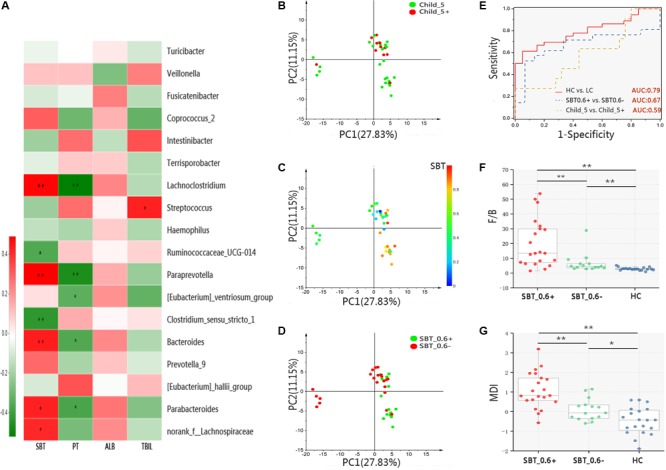
Microbiota study in patients bases on SBT grouping. (A) Color-coded Heatmap displaying the relationship between 18 bacterial genera, SBT and Child–Pugh score indicators (PT, ALB, and TBIL). The color scale represents the correlation coefficient. Red: positive correlations; Green: negative correlations, Spearman’s rank test, ∗p < 0.05, ∗∗p < 0.01. PCA of samples from LC, color coding base on (B) categorical variable of Child–Pugh score [threshold = 5, (Pr(>F) = 0.24, pMANOVA)], (C) continuous variable of SBT value and (D) categorical variable of SBT value [threshold = 0.6, Pr(>F) = 0.0068, pMANOVA)]. (E) ROC analysis assess the predictive model performance between LC and HC (AUC = 0.79); SBT_0.6– and SBT_0.6+ (AUC = 0.67); Child_5 and Child_5+ (AUC = 0.59). (F) F/B ratio and (G) MDI comparison between groups, Box plot illustration was provided in Figure 1, Wilcoxon rank-sum test, ∗p < 0.05, ∗∗p < 0.01. HC (n = 20), Child_5 (n = 25), Child_5+ (n = 11), SBT_0.6– (n = 21), SBT_0.6+ (n = 15).